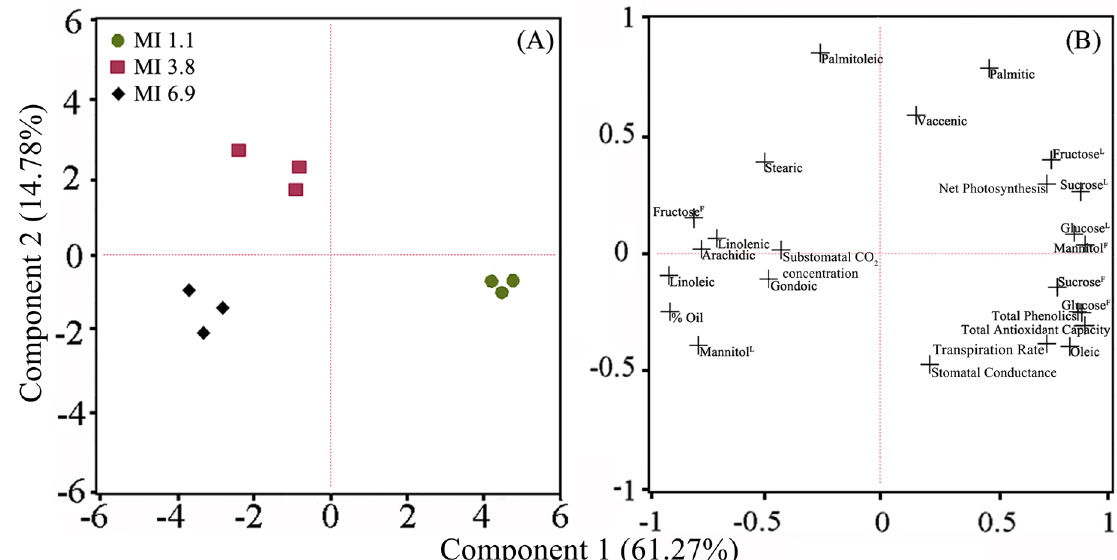
Fig. 3: Principal Component Analysis (PCA) in Koroneiki olive tree according to 24 variables (related to leaf photosynthetic parameters and sugars, and fruit sugars, oil content, fatty acids and total antioxidants) affected by seasonal growth - maturity index, in 2010 (A and B). In PCA: A, Score plot; B, Load plot. In A: MI, maturity index; circle, green olives at MI 1.1; squares, red olives at MI 3.8; rhombus, black olives at MI 6.9. In B: dagger indicates the position of each variable in load plot. Numbers in parentheses correspond to the percentage of the total variance explained by each component. L , leaf; F ,